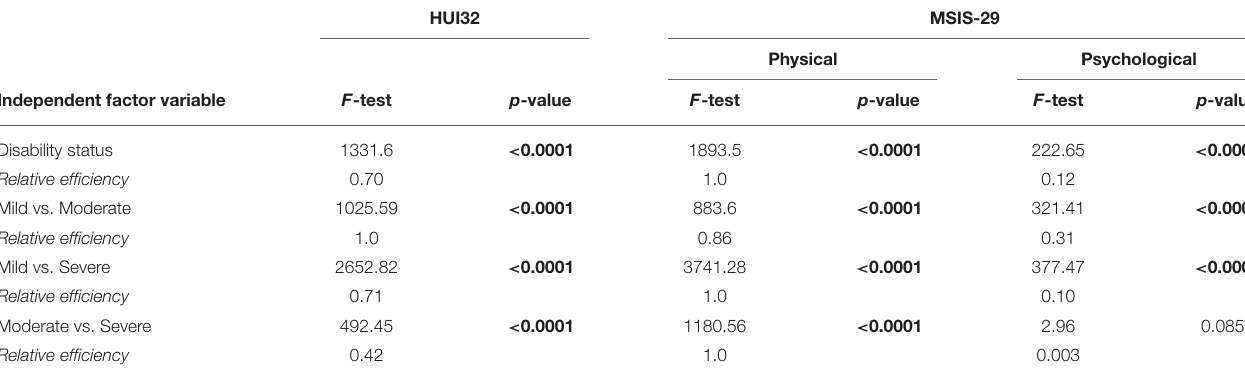
TABLE 3 | Analysis of covariance for health-related quality of life measures by disability level*.